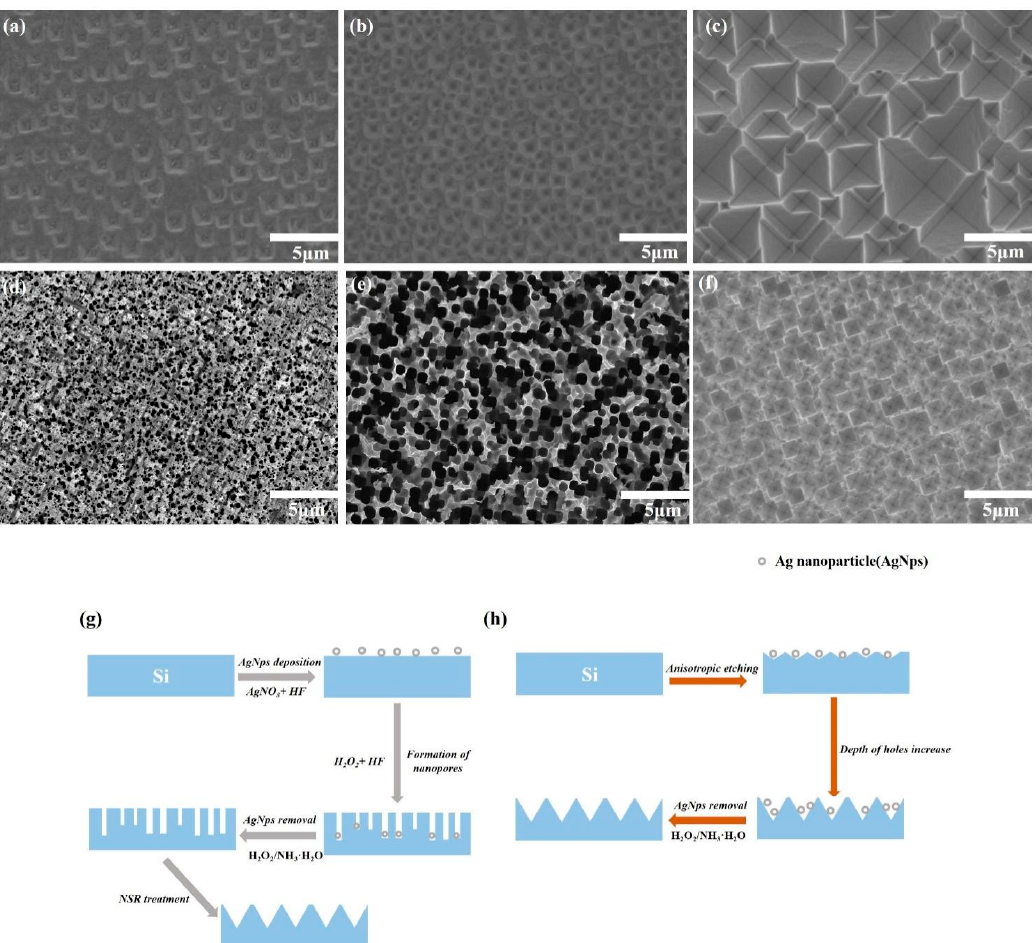
Figure 9. SEM images of inverted pyramid formation process via Ag@PVP–ACE ( a – c ), nanopore formation and NSR treatment ( d – f ) and corresponding schematic diagram of inverted pyramid fabrication process by NSR treatment technology ( g ) and Ag@PVP–ACE ( h ).